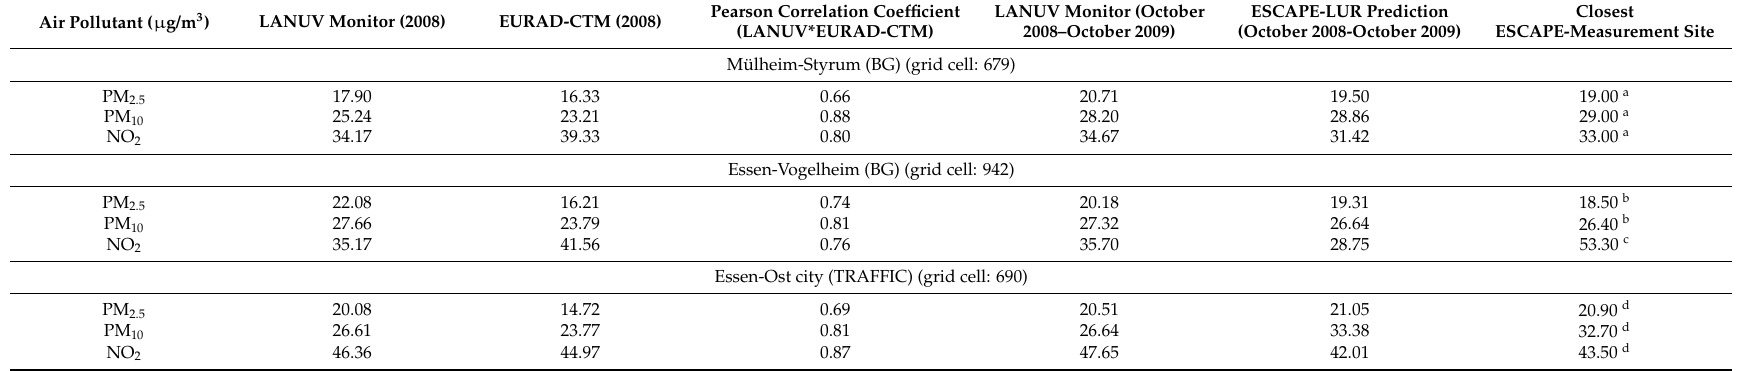
Table 4. Yearly mean air pollution concentrations measured at routine monitoring sites (background (BG) and traffic (TRAFFIC)), provided by LANUV, modeled by EURAD-CTM (for the respective grid cell), modeled by ESCAPE-LUR (at the location of the routine monitoring sites) and measured adjusted yearly mean at the closest ESCAPE site plus Pearson’s correlation coefficient between LANUV daily measurements and EURAD-CTM daily estimations for PM 2.5 , PM 10 , and NO 2